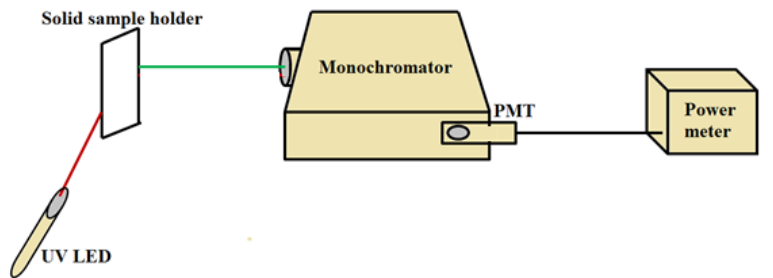
Figure 10. Fluorescence intensity spectroscopy setup.